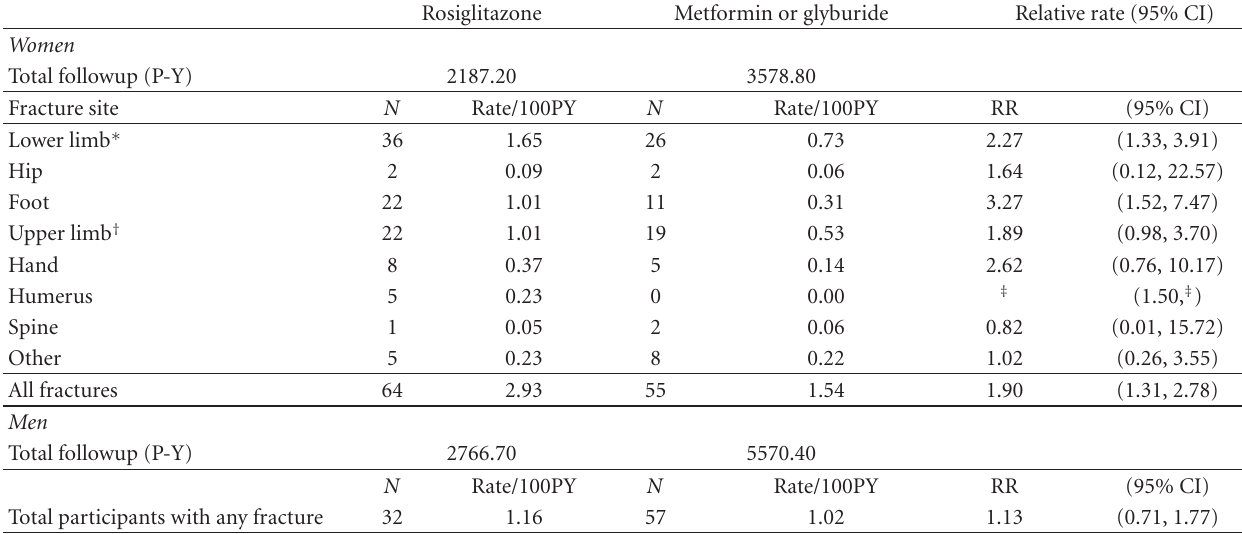
Table 1: Fracture rates comparing rosiglitazone with metformin or glyburide in ADOPT study. Table adapted from a Letter to Health Care Providers issued by GSK